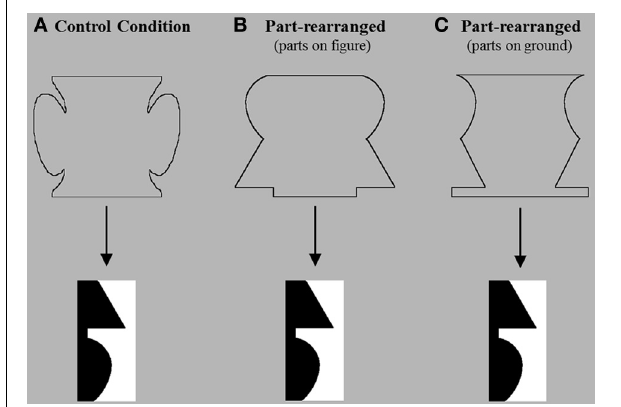
FIGURE 2 | Example stimuli in each priming condition. In these examples, an upright lamp is depicted in the familiar region (here, in black and on the left side) of the bipartite display. Experiment 1 used (A) the control condition, in which the prime contains no parts of that lamp, and (B) the part-rearranged condition, in which the prime contains the lamp’s familiar parts (i.e., the lampshade, the neck, and the base) rearranged into a novel configuration and depicted on the figure side of the vertical borders. Experiment 2 used (C) the part-rearranged condition in which the parts were suggested on the groundside of the outline prime’s vertical